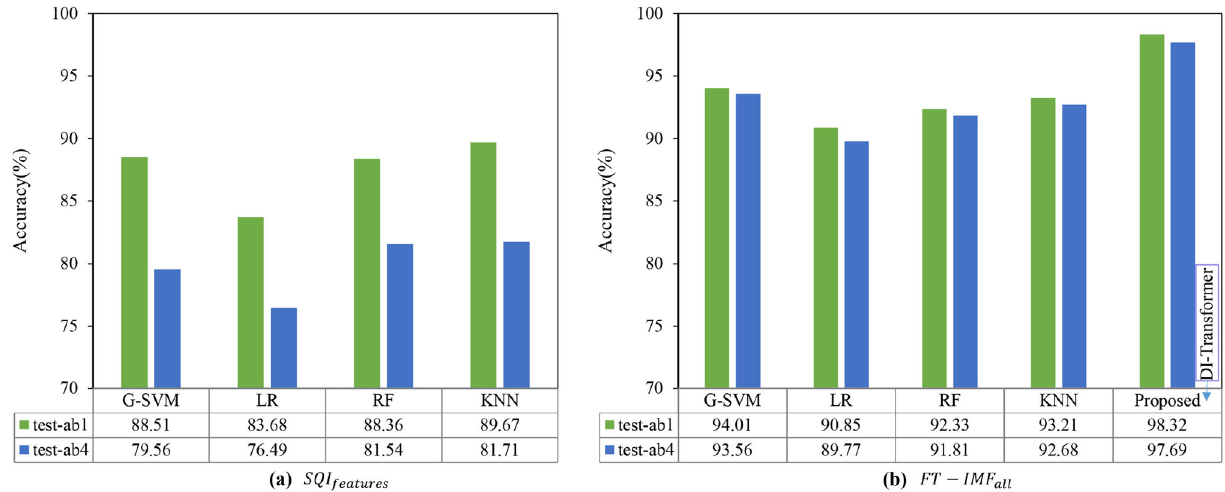
Fig. 10 The ability of FT-IMF all to recognize signal segments containing MA (em and ma)-contaminated ECG. a The results on classification models built with SQI features features. b The results on classification models built with FT-IMF all features